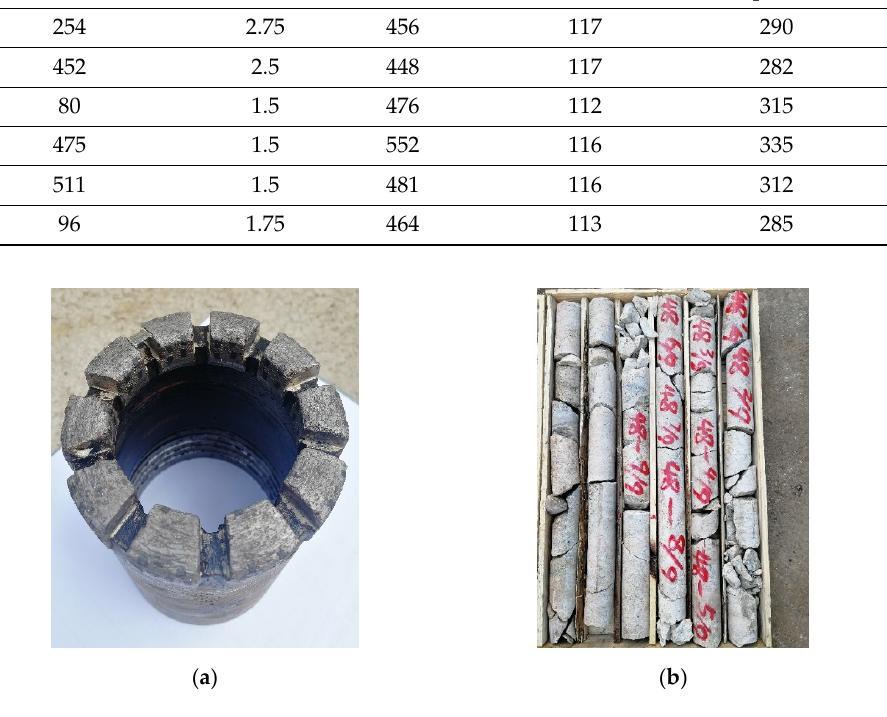
Table 4. Statistics on bit ‐ drilling efficiency of diamond core bit in Pingdu Hole 28ZK5.